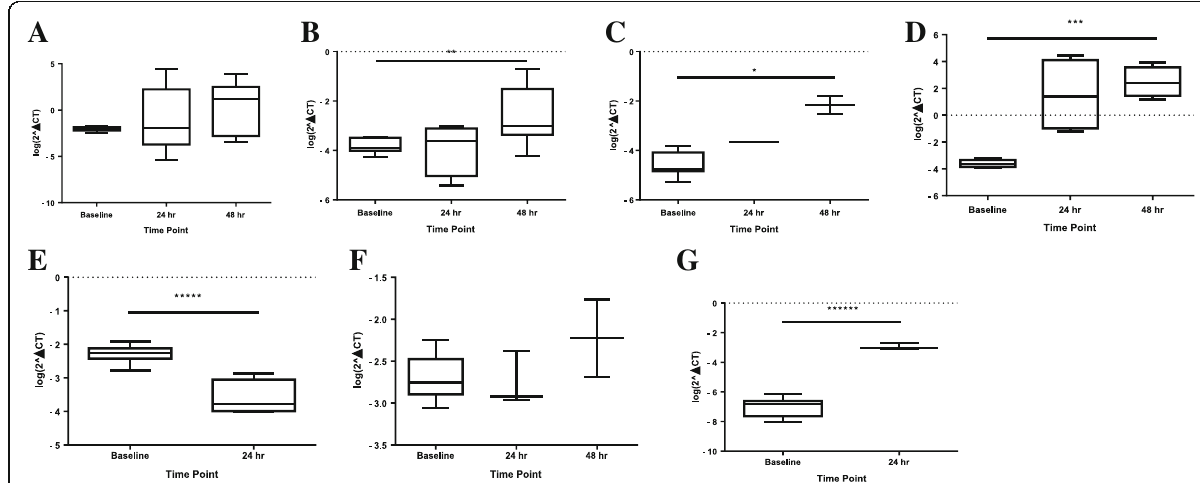
Fig. 1 Log transformed virulence factor RNA transcript expression in baseline cultures and supernatants post-macrophage infectivity at 24 and 48 h compared by Kruskal-Wallis or Mann-Whitney for the following targets: pooled expression ( a ), cpb ( b ), gp63 ( c ), mpi ( d ), hsp70 ( e ), hsp90 ( f ), and hsp100 ( g